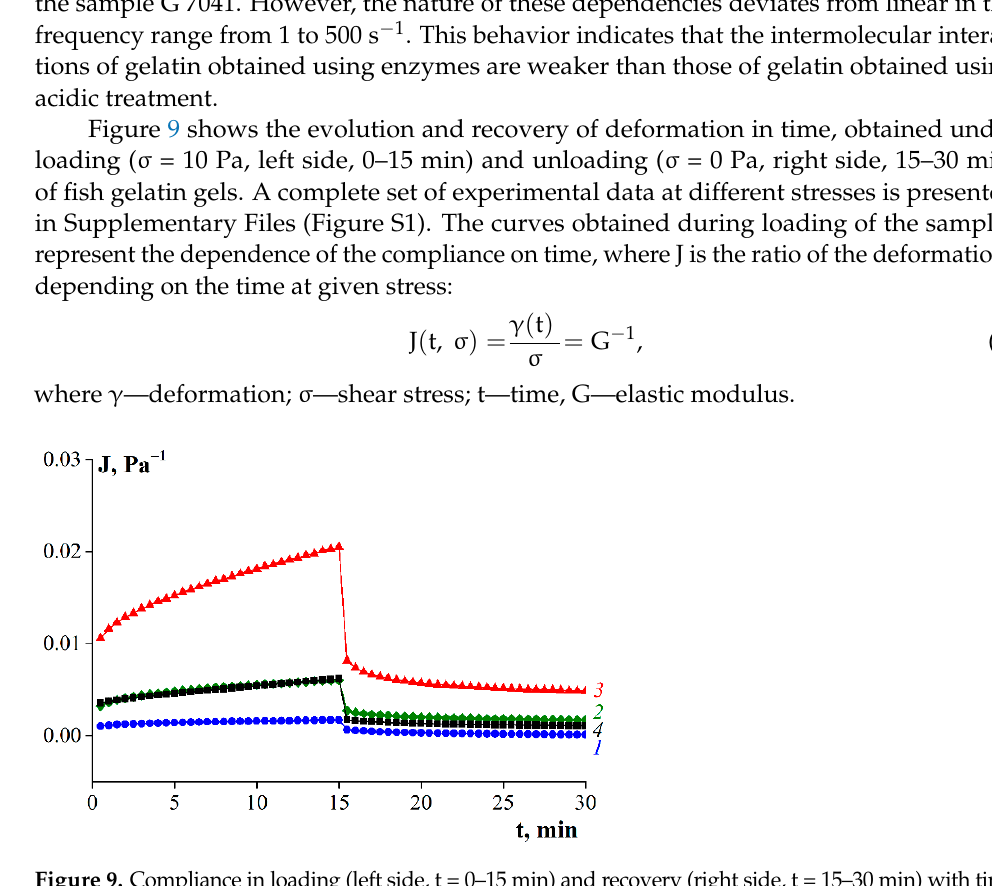
Figure 9. Compliance in loading (left side, t = 0–15 min) and recovery (right side, t = 15–30 min) with time at T = 6 °C and σ = 10 Pa, where: 1—G1, 2—G2, 3—G3, 4—G 7041. Gelatin concentration was 10 wt.%.